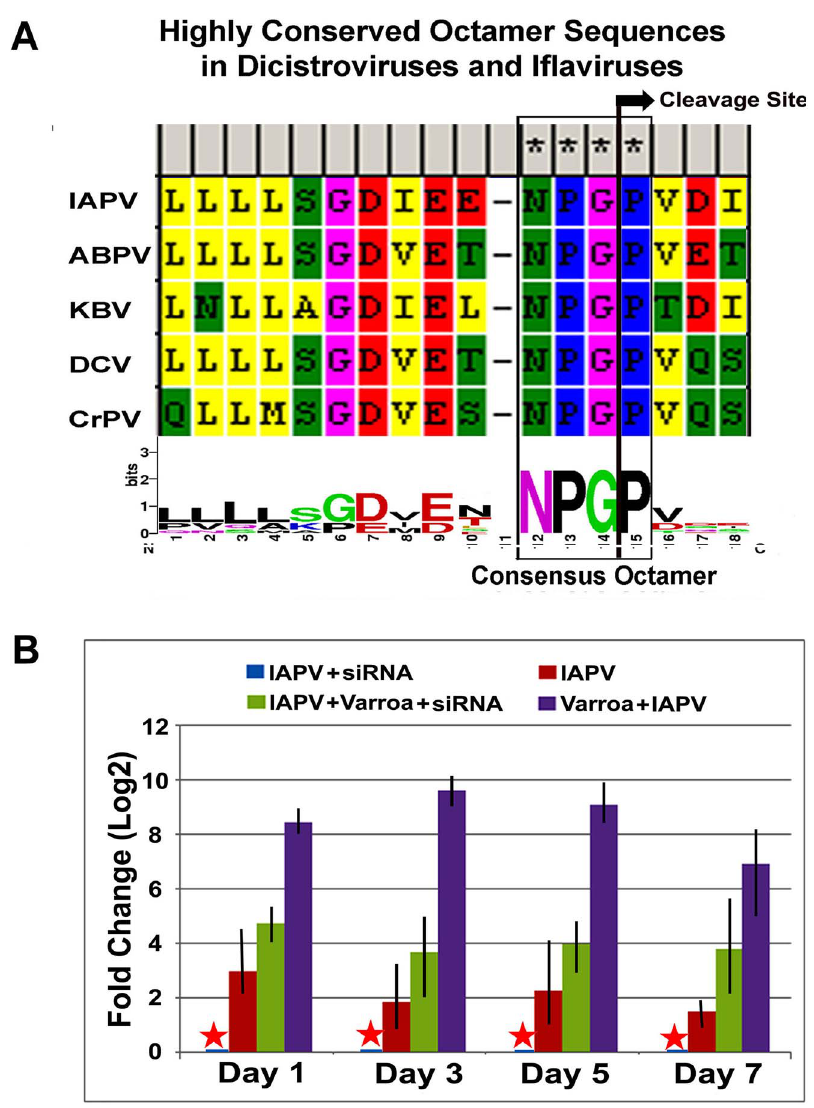
Figure 8. IAPV-encoded putative suppressor of RNAi. ( A ) Highly conserved octamer sequences identified in dicistroviruses. A putative viral suppressor of RNAi (VSR) is presumably located upstream of DvExNPGP. The cleavage site between the glycine and proline is marked by an arrow. ( B ) Quantitative analysis of the effects of silencing putative VSR on IAPV replication. The amount of negative stranded RNA of IAPV was measured by RT- qPCR, normalized to the corresponding b -actin in the same sample. The data shown represent the mean value for three separate experiments. Error bars represent the range of fold change.